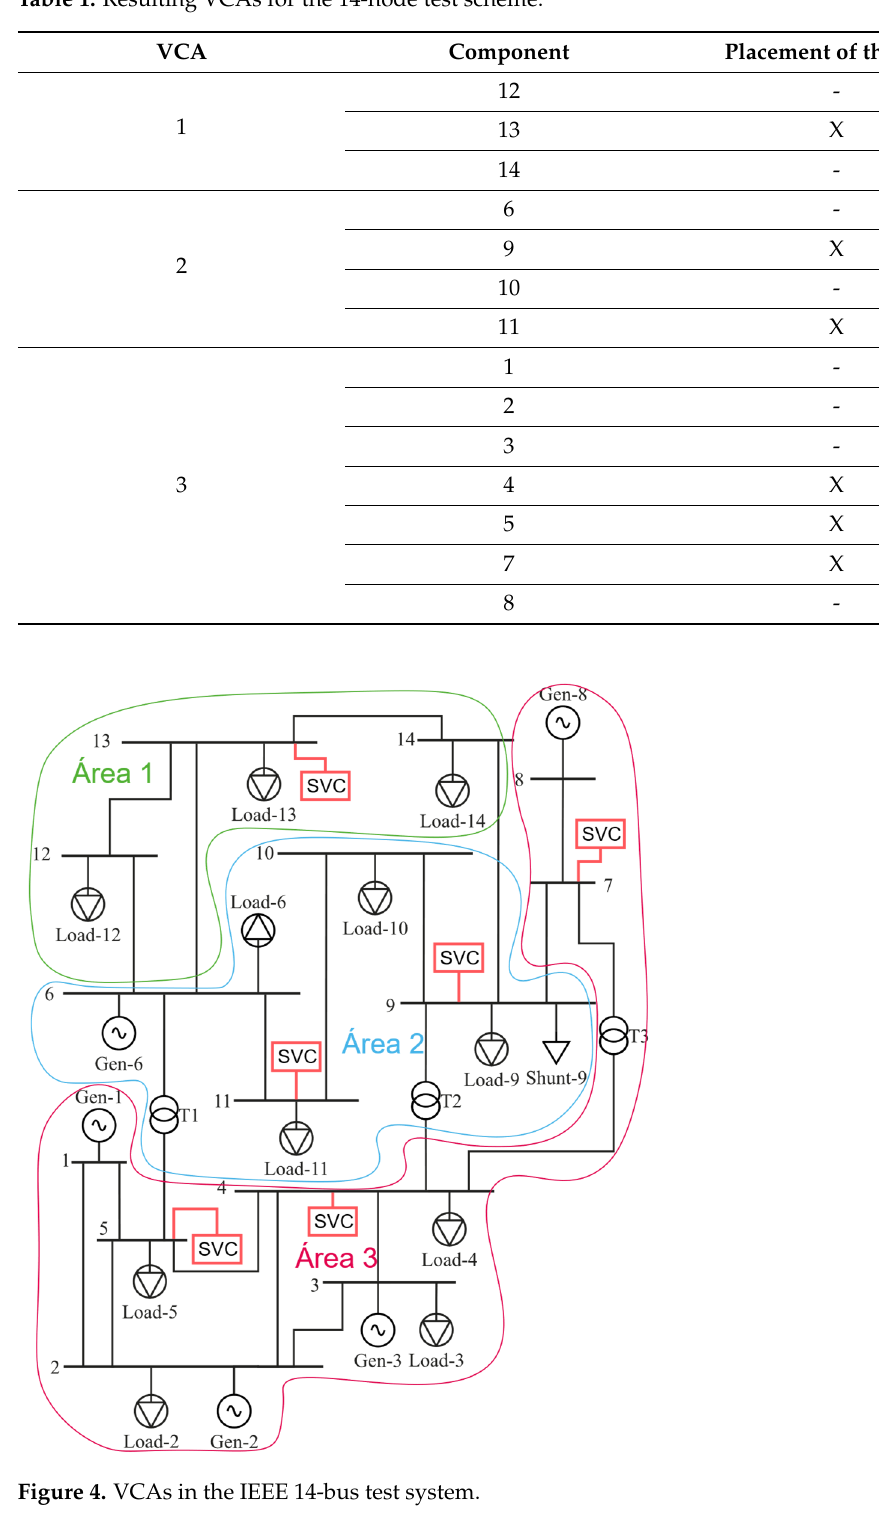
Table 1. Resulting VCAs for the 14-node test scheme.